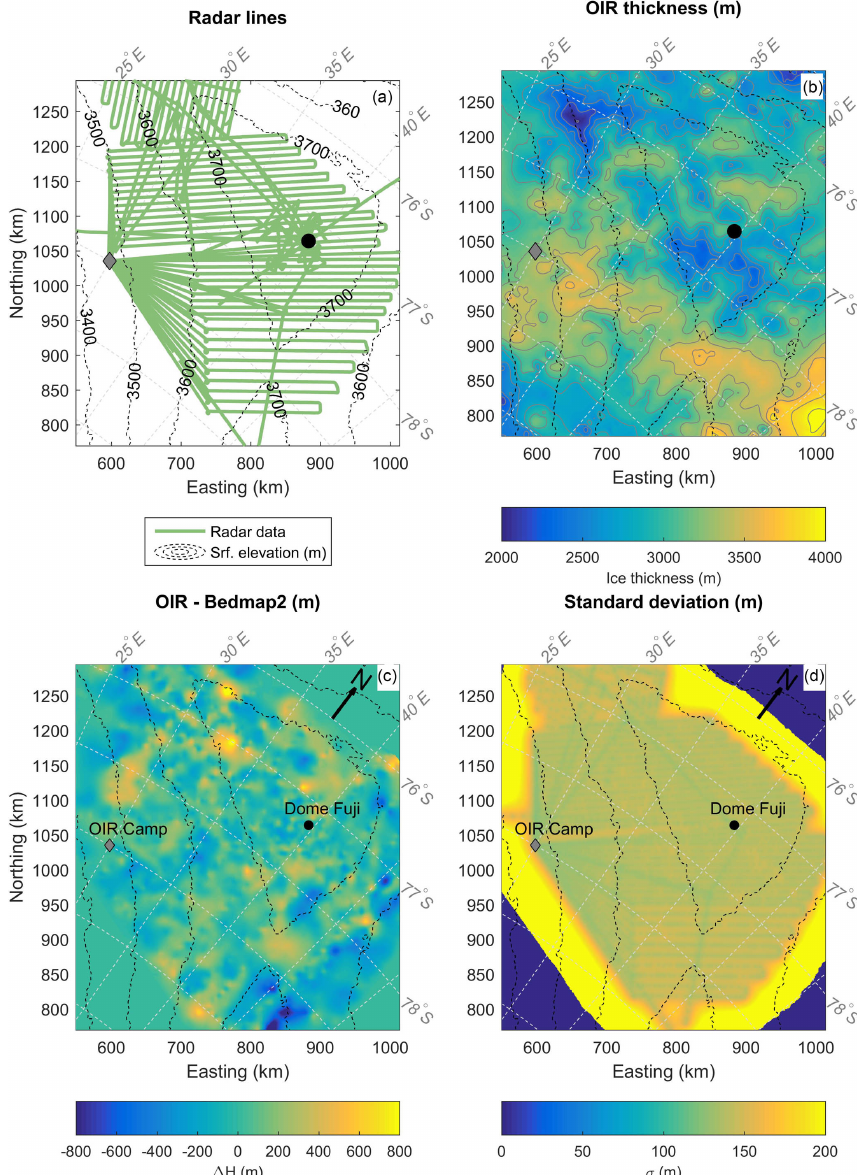
Figure 2. (a) The location of the radar lines from which the OIR dataset is constructed. (b) OIR ice thickness on grid (1km horizontal resolution). (c) The difference between the OIR ice thickness grid and the Bedmap2 ice thickness. Positive values indicate that the OIR data show larger ice thicknesses in an area. (d) The standard deviation of the kriged OIR ice thickness. In all maps Dome Fuji is indicated with a black dot and OIR camp with a grey